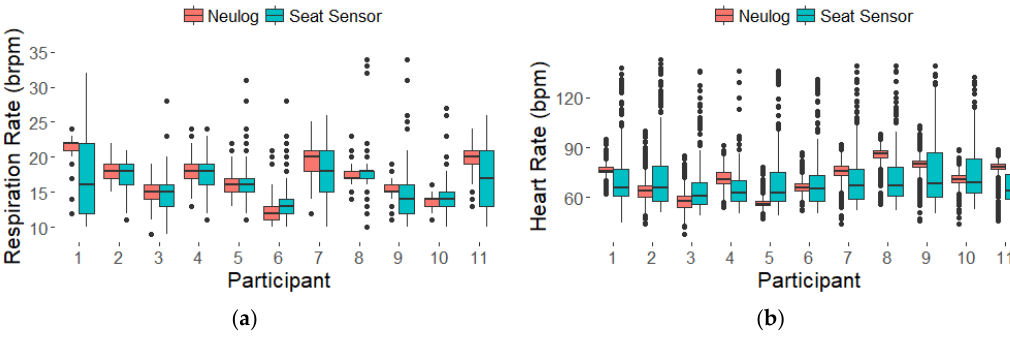
Figure 5. Boxplots of respiration ( a ) and heart ( b ) rates derived from the frequency analysis technique for all eleven participants over 30 ‐ min data collection. Table 2. Resting RR and HR Derived from Seat and Neulog Sensors for Eleven Participants